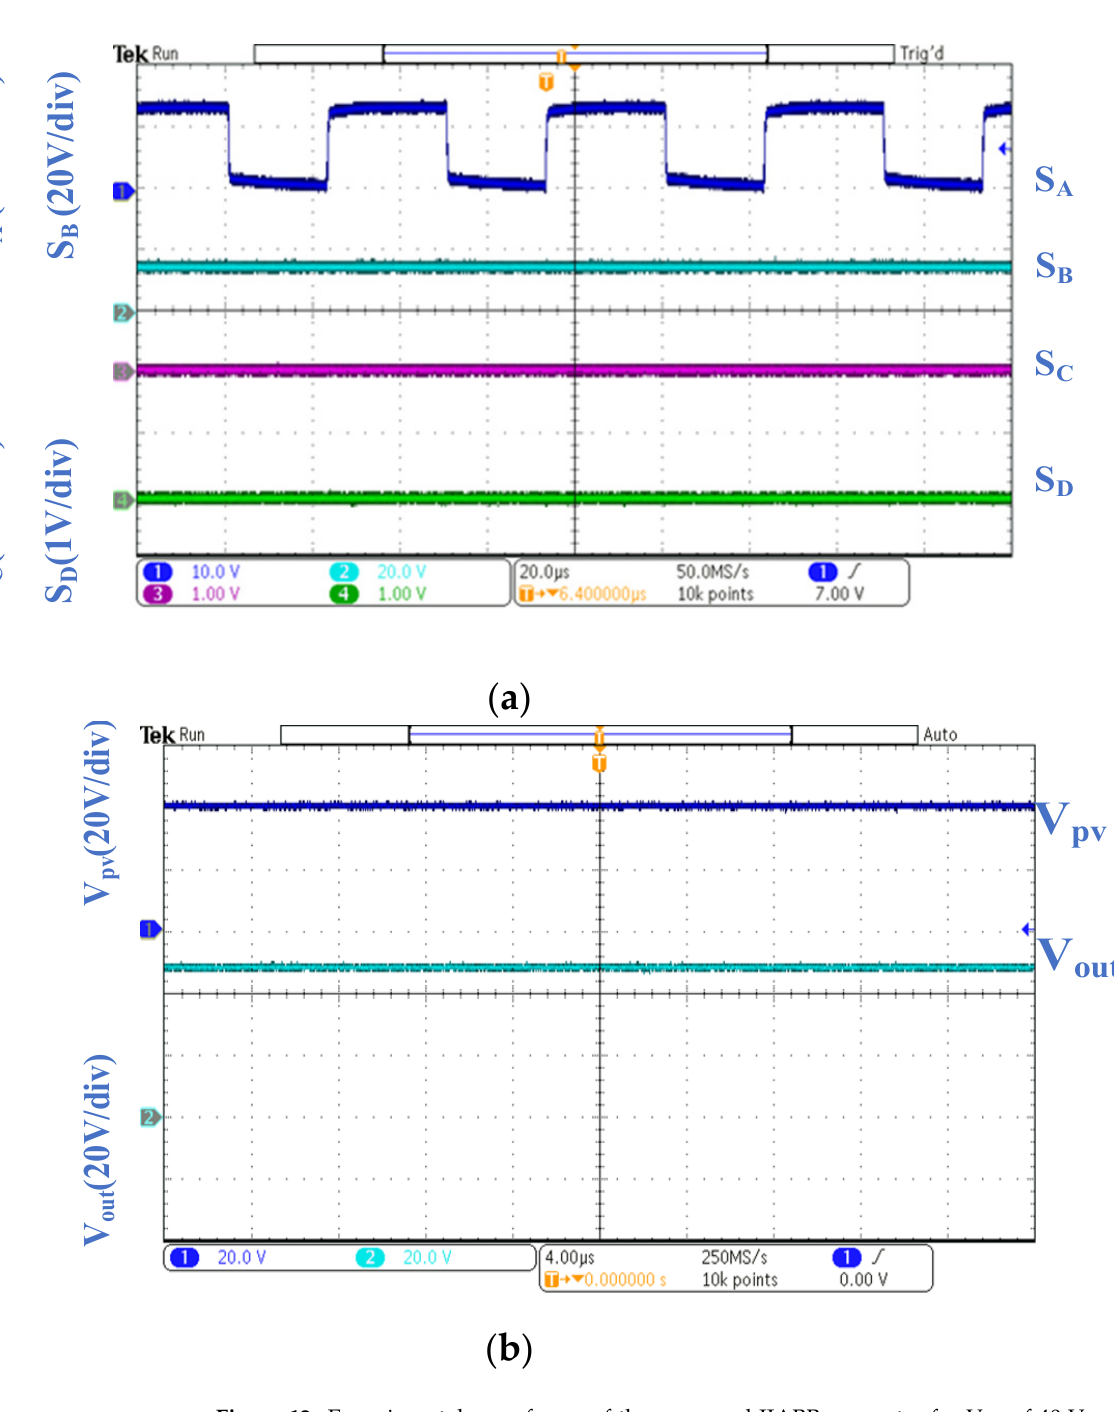
Figure 12. Experimental waveforms of the proposed IIABB converter for V pv of 40 V and N = 1: ( a ) experimental waveforms of switches S A and S B are operating; S C and S D are not operating; and ( b ) waveforms of V pv = 40 V and output voltage V out = 48 V via an intelligent control strategy and HC MPPT algorithm at a duty cycle of 0.55.